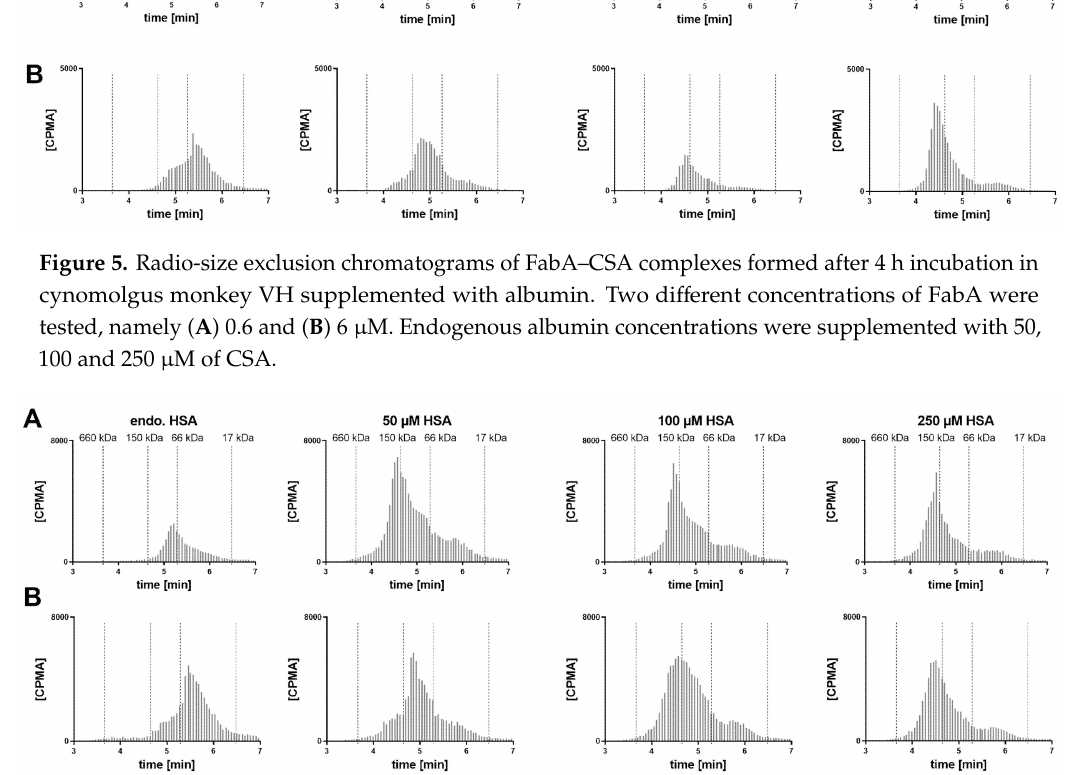
Figure 6. Radio-size exclusion chromatograms of FabA–HSA complexes formed after 4 h incubation in human VH and supplemented with increasing amounts of albumin. Two di ff erent concentrations of FabA were tested, namely ( A ) 0.6 and ( B ) 6 µ M. Endogenous albumin concentrations were supplemented with 50, 100 and 250 µ M of HSA.